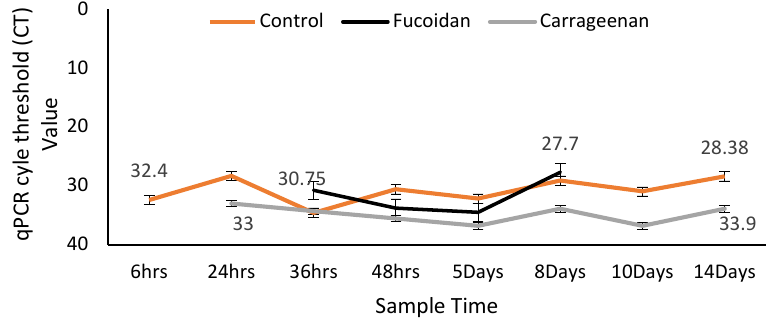
Figure 6. Quantitative PCR cycle threshold ( CT ) values shown at the start and end of the trial for each oyster group ( fucoidan and carrageenan treated and untreated ( control )). A CT value > 37 is uninfected while the lower the CT value the higher the viral load being detected . Overall, the carrageenan treated oysters had a significantly ( p value 0.01) higher prevalence ( 60 . 8 %) of Vibrio spp . ( subsample sequenced as V . splendidus ) by PCR, followed by the fucoidan treated oysters ( 21 . 8 %) and the control non - treated oysters ( 17 . 4 %) ( Figure 7 ).